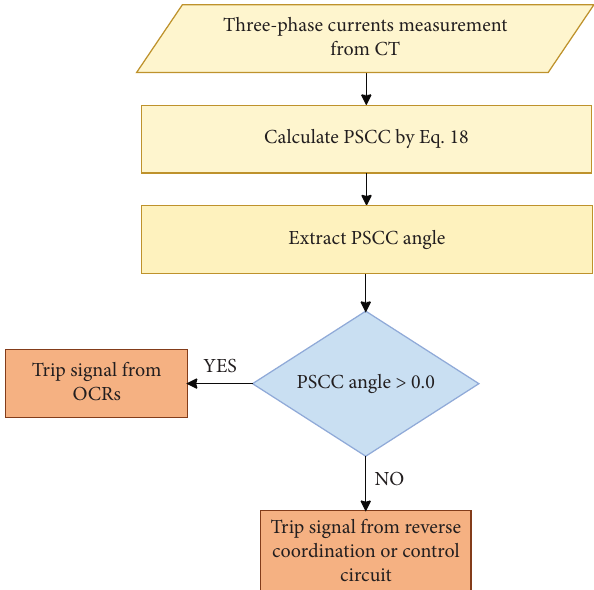
Figure 4: Flowchart for the proposed protection